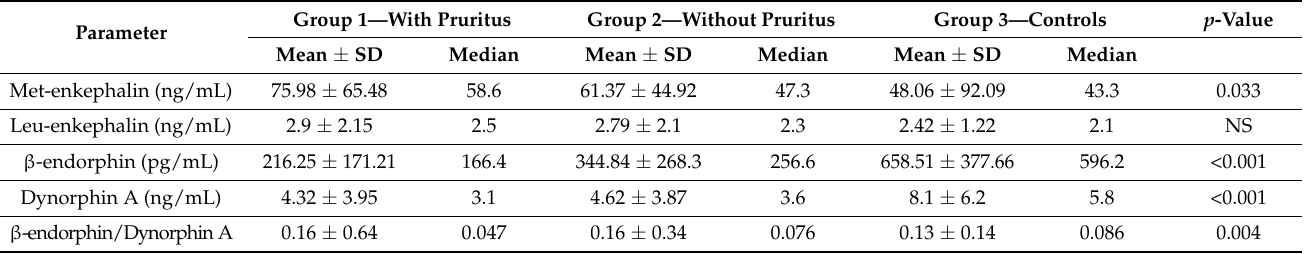
Figure 5. Leu-enkephalin concentrations in all study groups. Table 1. Concentrations of Met-enkephalin, Leu-enkephalin, β-endorphin, and Dynorphin A in serum in the studied group.